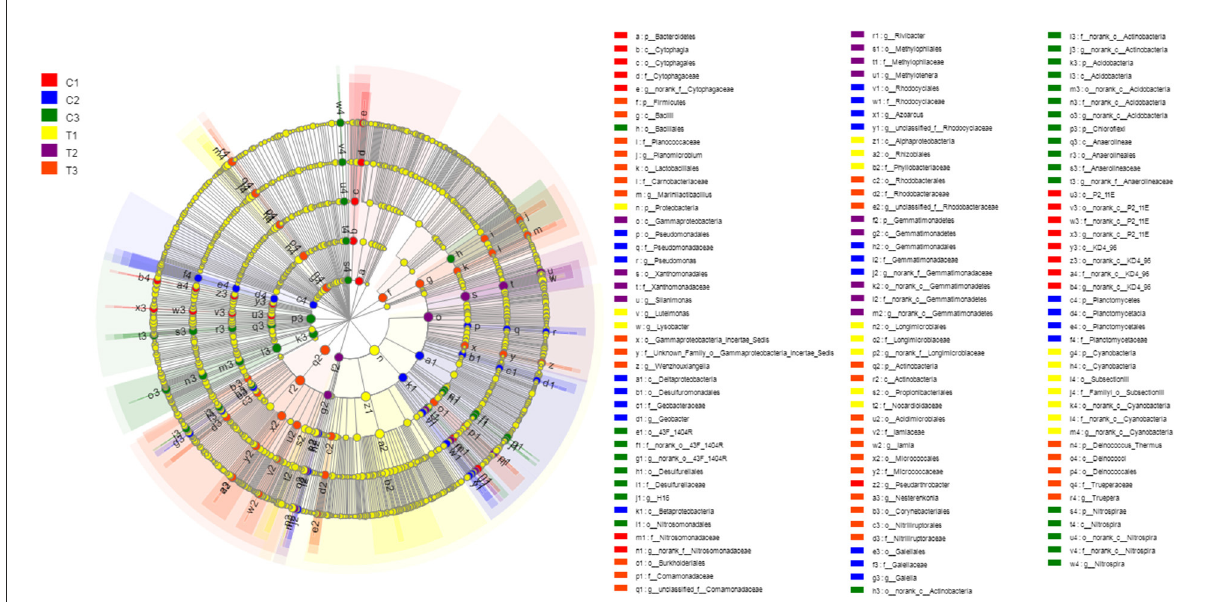
FIGURE10 LEfSe was used to discriminate the microbial communities of all soil samples. Significantly affected microbial taxa were shown in LEfSe multi-level species hierarchy tree diagram. All data in the experiment represent three independent